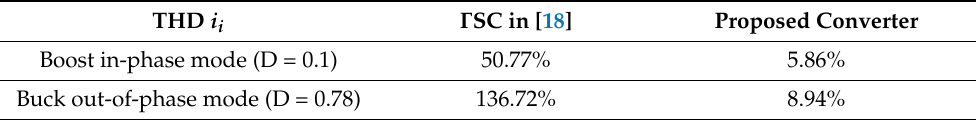
Figure 20. Simulation waveforms of the input current for: ( a ) boost in-phase operating mode in the proposed converter, ( b ) buck out-of-phase operating mode in the proposed converter, ( c ) boost in-phase operating mode in the conventional AC Γ-source converter [18], ( d ) buck out-of-phase operating mode in the conventional AC Γ-source converter [18]. Table 3. THD i i in the proposed converter and Γ SC in [18].